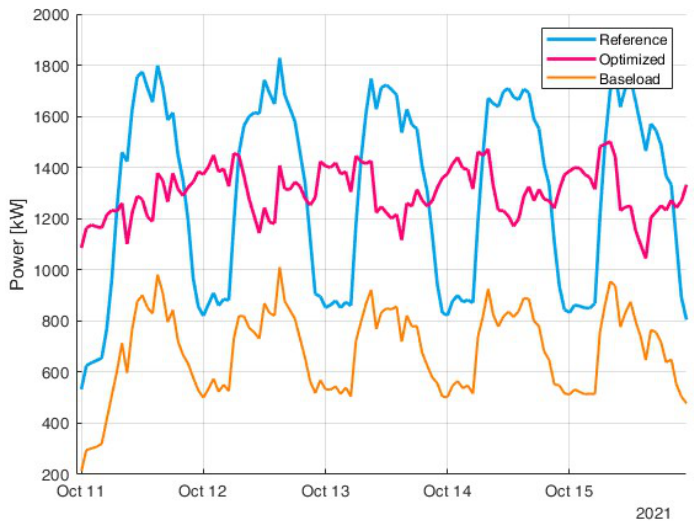
Figure 14. Zoom of the comparison between the reference load (in blue) and the optimised one (in purple). The orange load is the baseload that cannot be modified by the